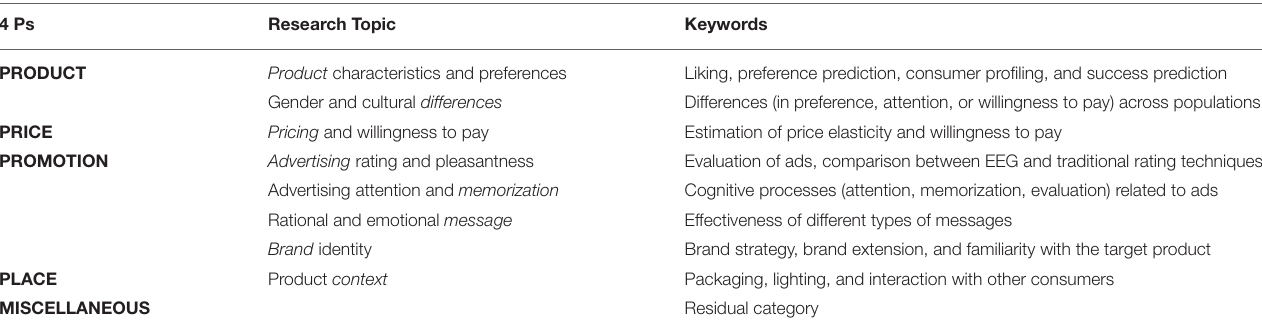
TABLE 1 | Classification: topics and research questions. 4